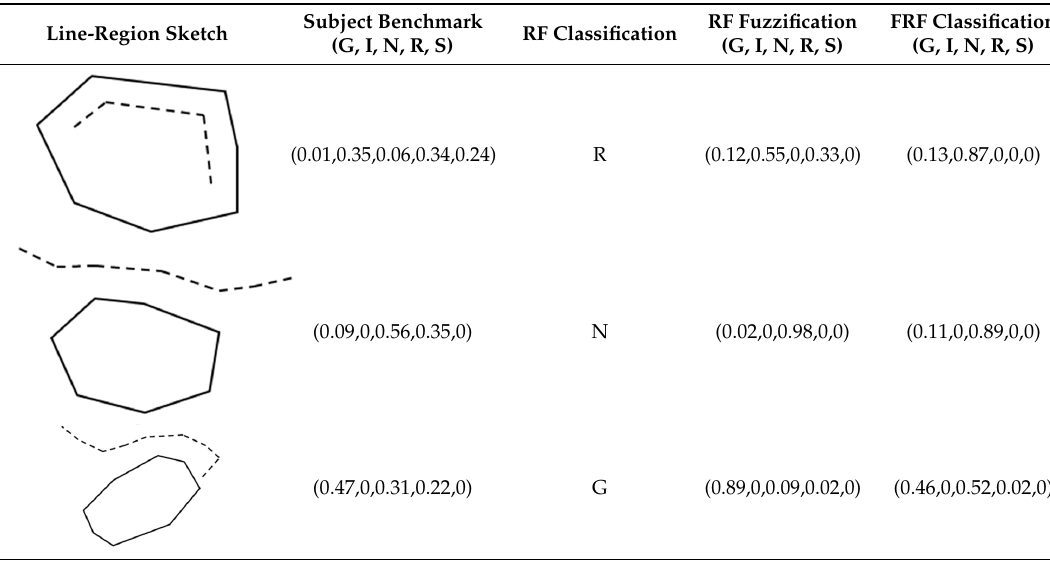
Table 7. Examples of line-region sketches and classification results. Table 3. Line-region sketches for evaluation of suitability.